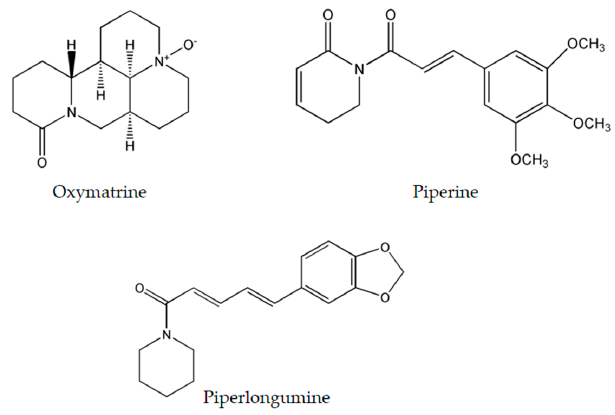
Figure 4. Chemical structure of most researched emerging plant-derived alkaloids oxymatrine, piperine and